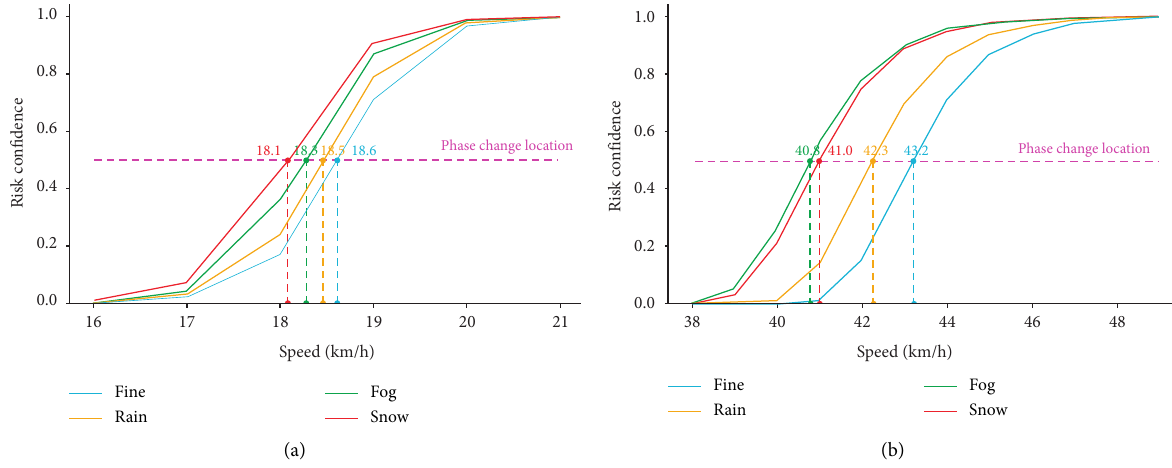
Figure 23: (a) Comparison of fatigue driving risk. (b) Comparison of driving risk probability under different weather